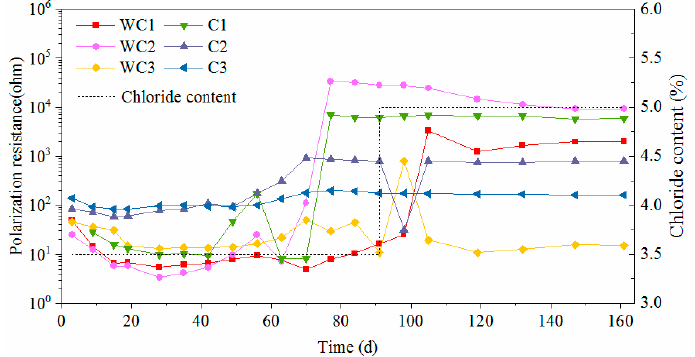
Figure 14. Polarization resistance of HRB500 carbon steel.